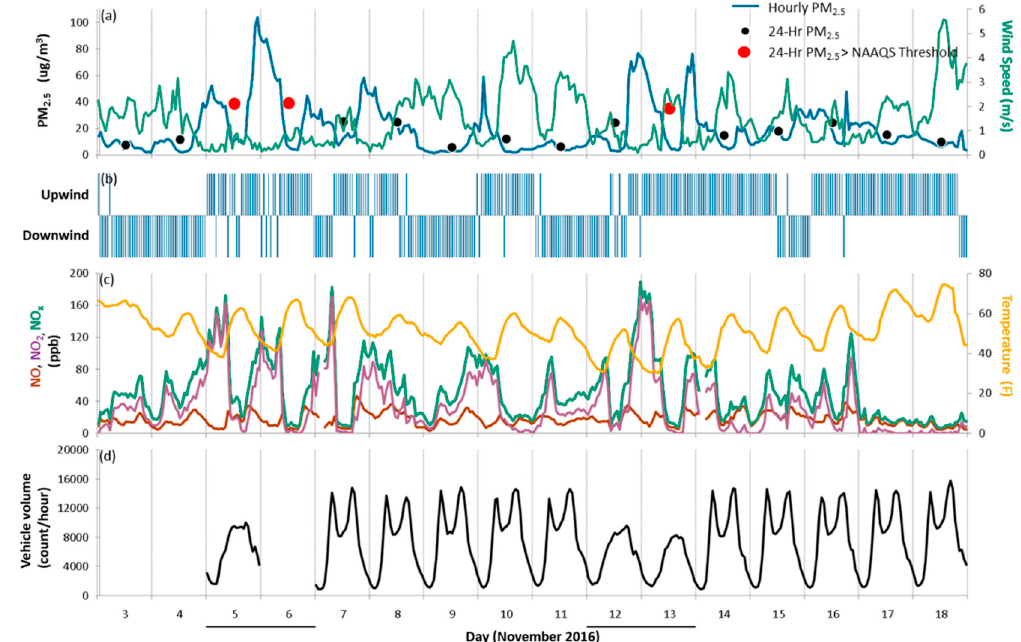
Figure 7. Indianapolis case characterization. Time series of meteorological, air quality, and traffic-related data from 3–18 November 2016, at the Indianapolis-0087 near-road monitoring site: ( a ) 1-hour PM 2.5 concentrations (blue line), 24-hr PM 2.5 concentrations (black and red dots, where red dots highlight 24-hour PM 2.5 concentrations that exceeded the 35 µg/m 3 NAAQS threshold), and wind speed (green line); ( b ) wind component (downwind means the near-road monitor was downwind of I-70, with winds originating from 240 to 60°); ( c ) NO (red line), NO 2 (purple line), and NO x (green line) concentrations, and temperature (orange line); and (d) traffic volume (vehicle count per hour). Weekend days are underlined along the x-axis.